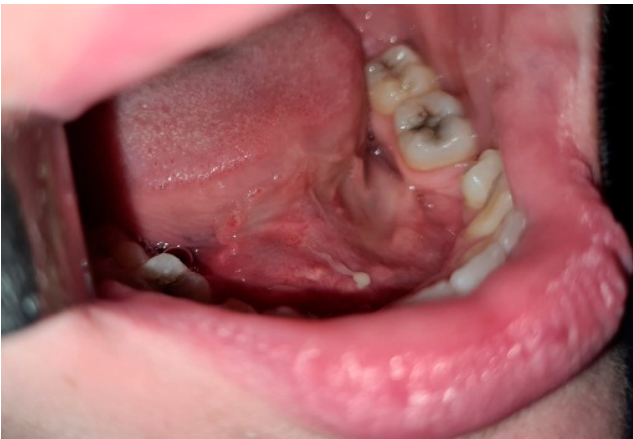
Figure 3. Intraoral view-oral floor bulging, purulent secretion at the Wharton duct orifice.